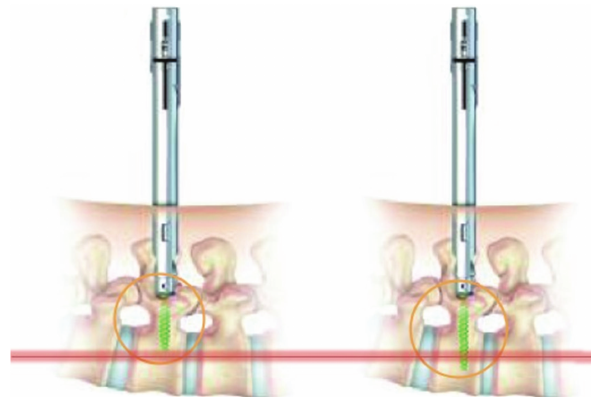
Figure 2: The cement is extruded through the fenestrations to fill the spaces inside the osteoporotic cancellous bone. The cement used is PMMA bone cement (Vertebroplastic, DePuy Spine, Johnson & Johnson).